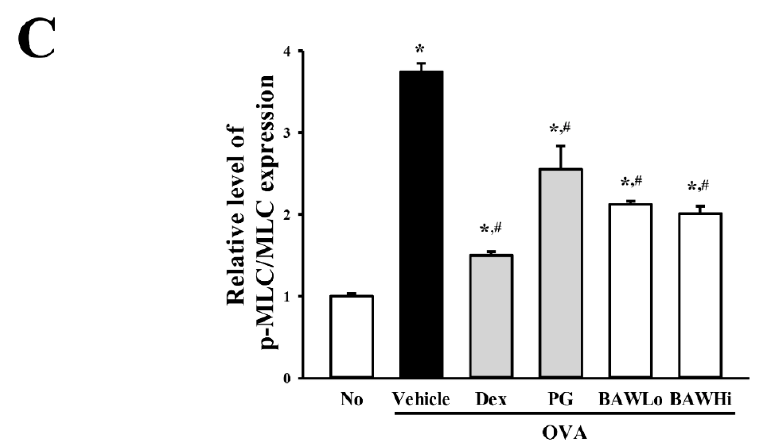
Figure 7. AChE activity and AChR M3 downstream signaling pathway of smooth muscle cells. ( A ) Measurement of AChE activity. After homogenization of lung tissue, AChE activity was measured using an Acetylcholinesterase Assay Kit that could detect as little as 0.01 mU AChE in a 100 µL assay volume (0.1 mU/mL). ( B ) Detection of MLC phosphorylation. Expression of MLC and p-MLC measured using western blot analyses with an HRP-labeled secondary anti-rabbit IgG antibody, and ( C ) the relative levels of each protein was calculated relative to the intensity of actin bands. The data shown represent the means ± SD ( n = 8). * indicates p < 0.05 compared to the No-treated group. # indicates p < 0.05 compared to the OVA + Vehicle-treated group.